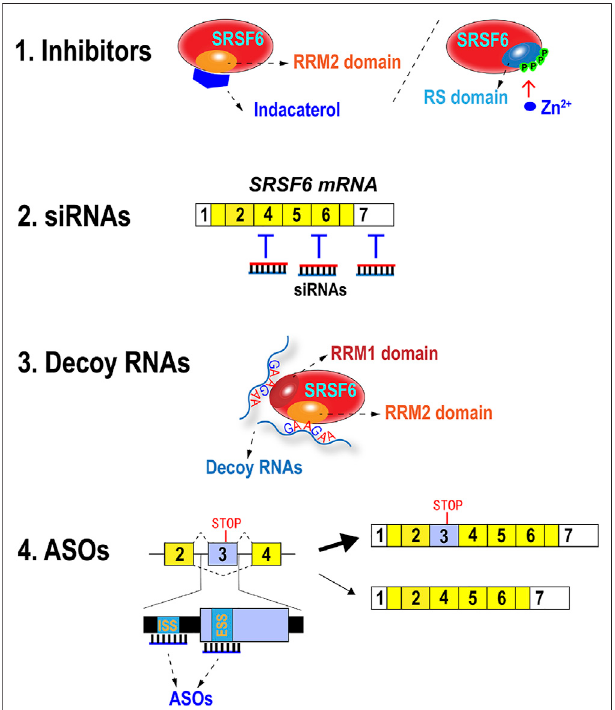
FIGURE 4 | Methods of inhibiting SRSF6 expression and functions. Indacaterol suppresses SRSF6 by binding to RRM2 domain. Zn 2+ can induce hyperphosphorylation of RS domain and abolish its RNA binding ability. SRSF6 mRNAs can be targeted and degraded by siRNAs. Decoy RNAs with SRSF6 binding motifs may block SRSF6 function. Antisense oligonucleotides targeting potential exonic splicing suppressor (ESS) or intron splicing suppressor (ISS) in or around exon 3 may promote exon 3